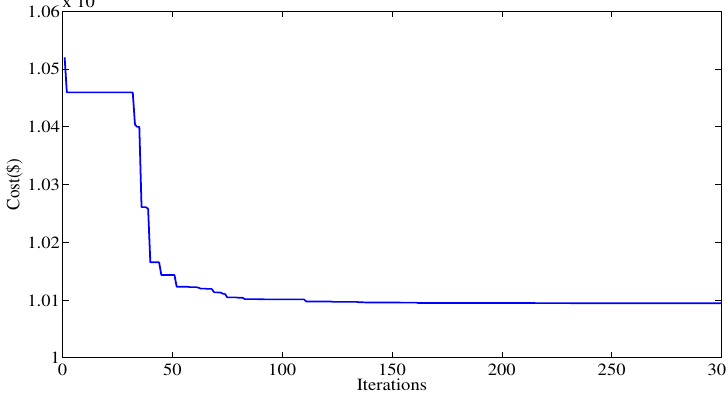
Figure 5. Convergence characteristics of the proposed IABC algorithm for 7-unit test system (Case